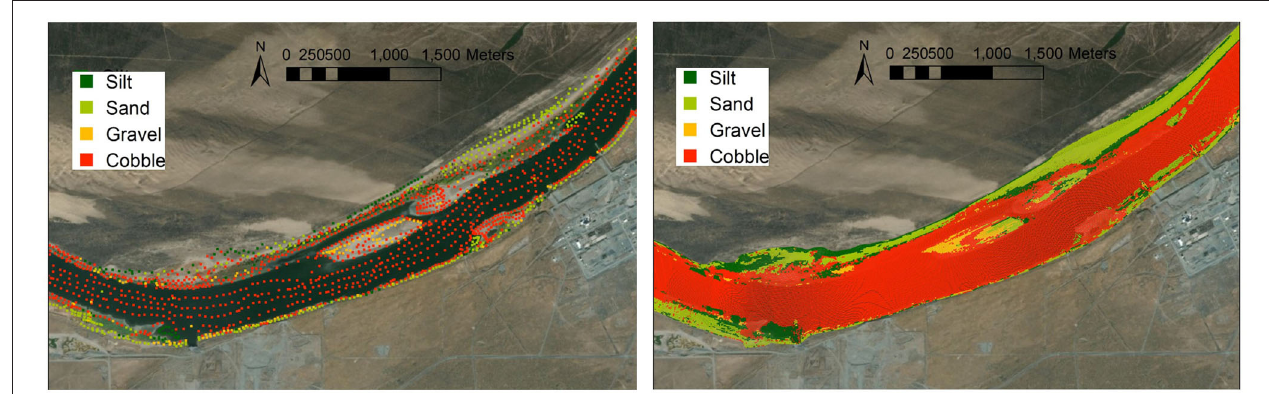
FIGURE 7 | The dominant substrate size distribution of the four lumped classes. The left panel is the ground-truthing and the right panel is the model prediction for each simulation grid.